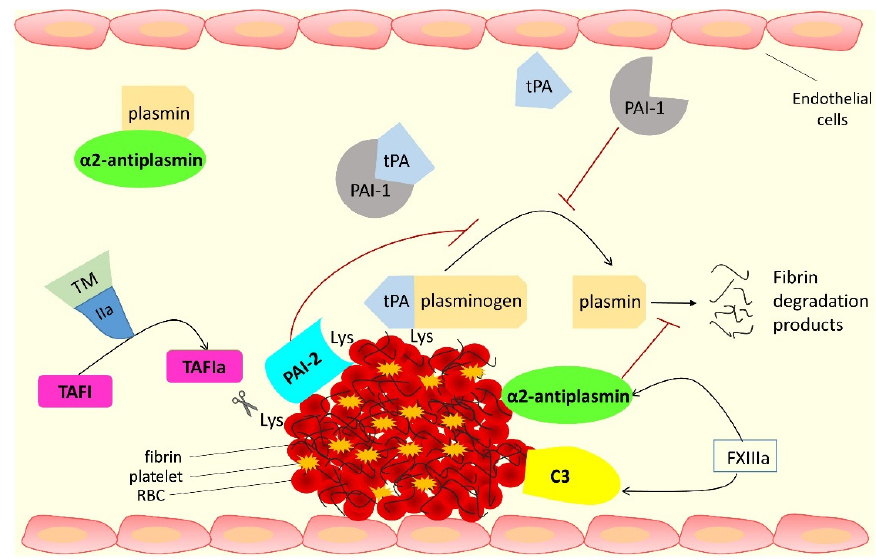
Figure 1. The role of antifibrinolytic proteins in the fibrinolytic process. The fibrin component of the thrombus is degraded by plasmin, generated by tissue plasminogen activator (tPA) activation of plasminogen. Anti-fibrinolytic protein plasminogen activator inhibitor-1 (PAI-1) binds tPA, pre- venting plasminogen activation. Alpha-2 antiplasmin ( α 2AP) forms a stable complex with plasmin in the circulation or becomes cross-linked into the fibrin clot by activated FXIII (FXIIIa), which makes the clot more resistant to fibrinolysis. Thrombin activatable fibrinolysis inhibitor (TAFI) is activated by thrombin (IIa) in complex with thrombomodulin (TM). Activated TAFI (TAFIa) cleaves off lysine residues (Lys) from the fibrin surface therefore decreasing plasminogen and tPA binding, thus reducing plasmin generation. TAFI, as well as plasminogen activator inhibitor-2 (PAI-2), can also be cross-linked into the fibrin clot by FXIIIa. Complement C3 is bound and cross-linked to the fibrin clot by FXIIIa, causing prolongation of